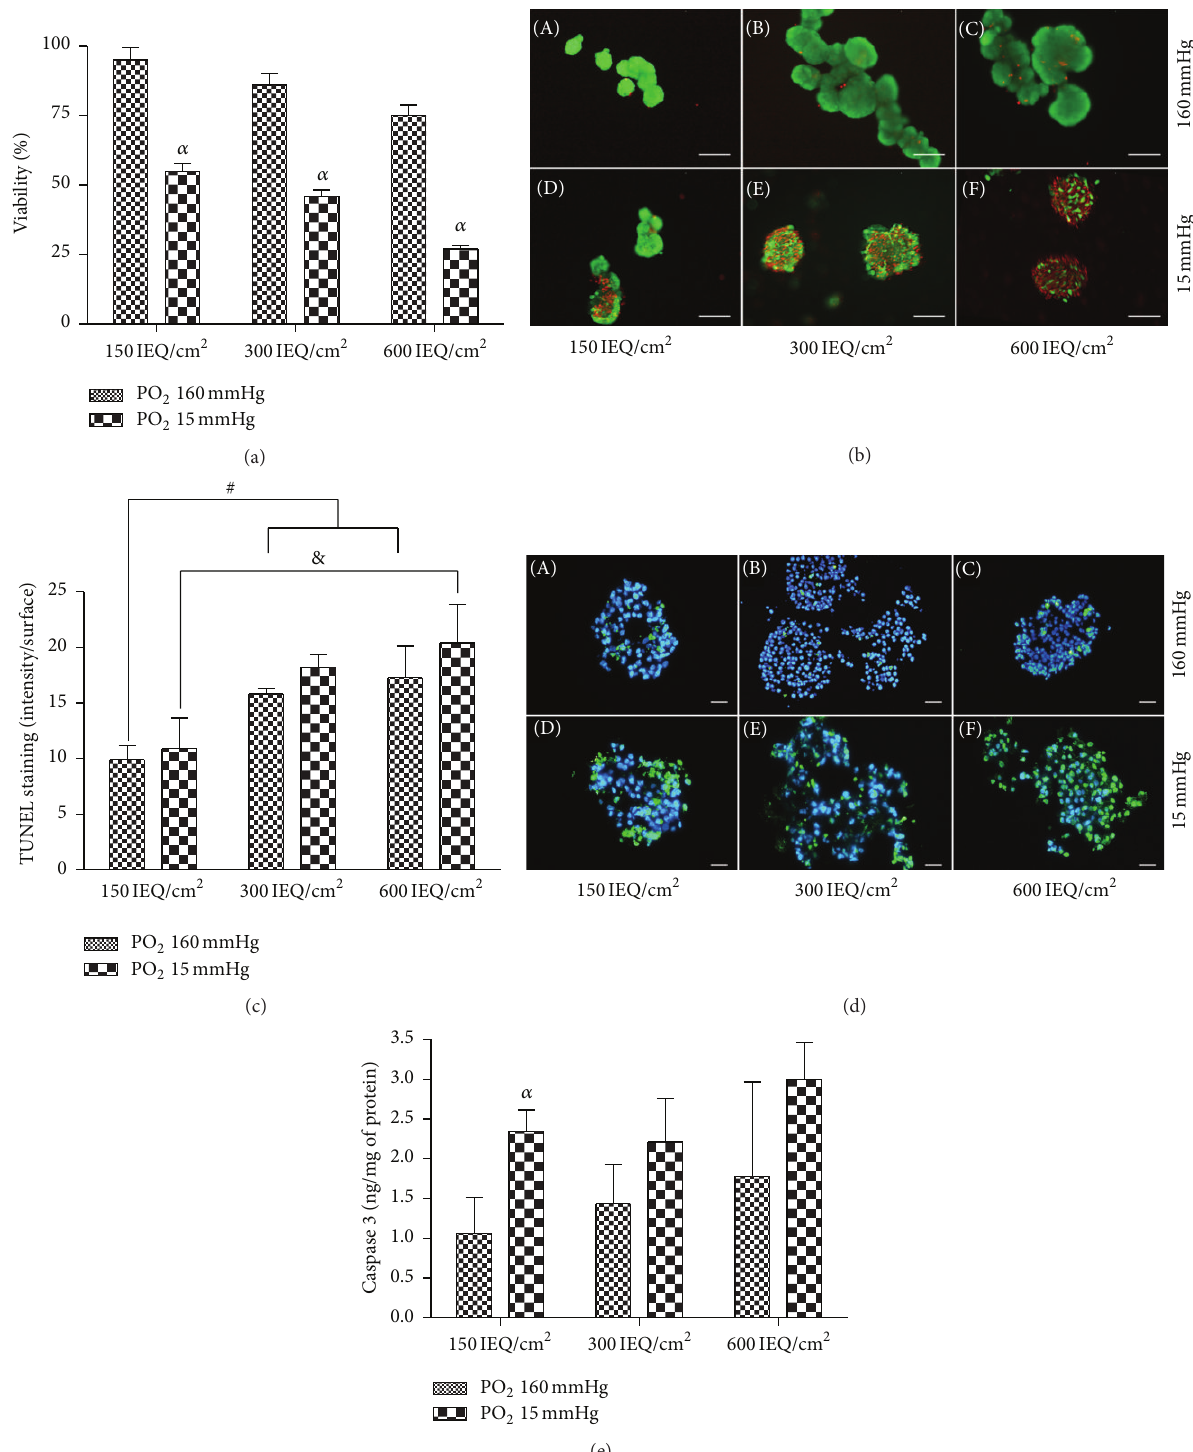
Figure 1: Islet viability. (a) Islet viability at each cell density after 24 hours in culture under both normoxic (PO 2 160mmHg) and hypoxic (PO 2 15 mmHg) conditions. (b) Representative fluorescein diacetate/propidium iodide (FDA/PI) stained images of islets cultured at 150, 300, or 600 IEQ/cm 2 under normoxia and hypoxia. Green staining (FDA) indicates that the cells are alive, while red staining (PI) indicates that the cells are dead. Scale bars = 100 𝜇 m. (c) Islet apoptosis at each cell density after 24 hours in culture under both normoxic (PO 2 160mmHg) and hypoxic (PO 2 15mmHg) conditions. (d) Representative images of TUNEL stained cells cultured at 150, 300, or 600 IEQ/cm 2 under normoxia and hypoxia. Blue staining highlights the cell nuclei (DAPI), and the green staining indicates apoptosis. Scale bars = 50 𝜇 m. (e) Caspase-3 activation at each cell density after 24 hours in culture under both normoxic (PO 2 160mmHg) and hypoxic (PO 2 15mmHg) conditions. 𝛼 𝑝 < 0.05 compared to the control, 𝛼𝛼𝛼 𝑝 < 0.001 compared to 600 IEQ/cm 2